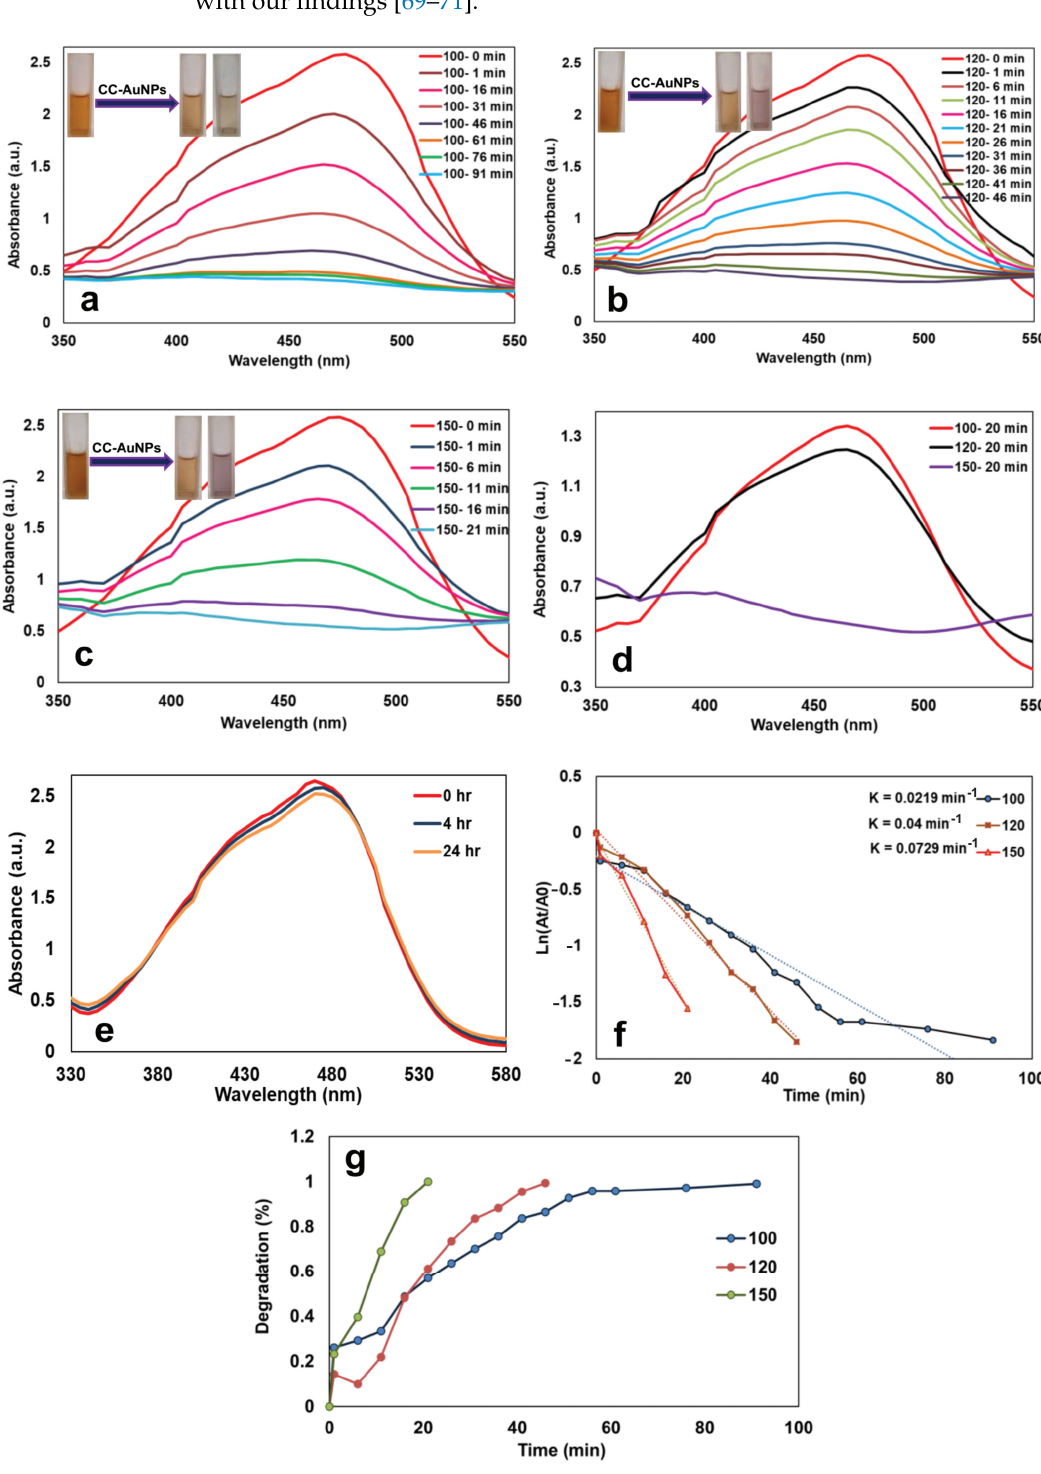
Figure 10. UV–Vis absorption spectra for the reduction of MO with NaBH 4 catalyzed by ( a ) 100 µL, ( b ) 120 µL, and ( c ) 150 µL of CC-AuNPs at the concentration 425 µg/mL, ( d ) the comparison of different volumes of CC-AuNPs. ( e ) UV–Vis spectra for the reduction of MO with NaBH 4 only without nanocatalyst; ( f ) the corresponding plots of ln(At/A0) vs. time, ( g ) degradation percentage of MO.